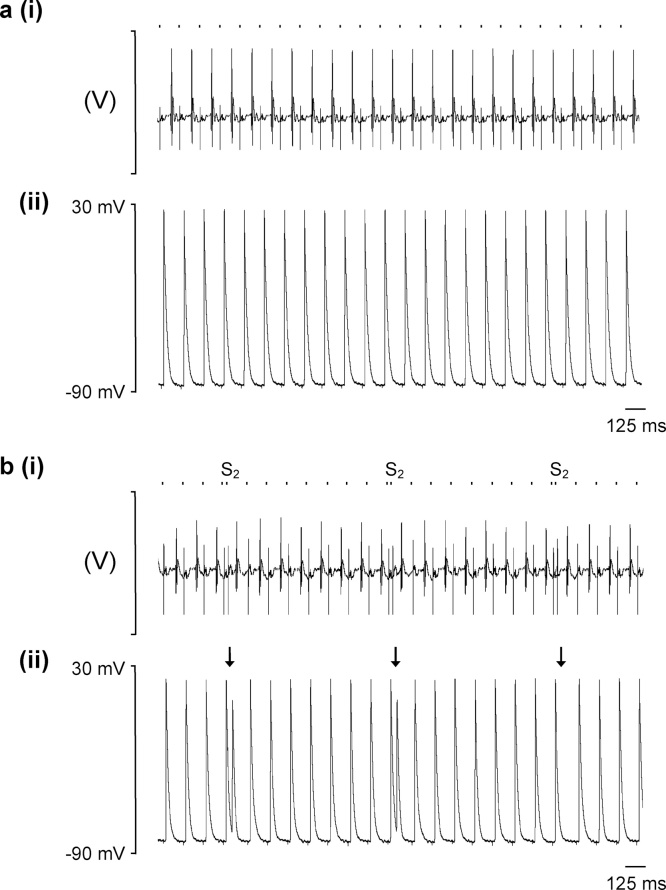
Typical recordings from Langendorff-perfused WT hearts during regular pacing and programmed electrical stimulation. Electrocardiograph (ECG) (i) and left atrial intracellular action potential (AP) recordings (ii) during (a) regular 8 Hz pacing and (b) a protocol imposing programmed electrical stimulation with a refractory outcome. The timings of stimulus delivery are given by the dashed bar above the AP recordings, and corresponding stimulation artefacts can be seen on the ECG and AP traces, preceding the respective complexes. In panel (B), arrows indicate the imposition of S2 extrastimuli. The first two S2 stimuli trigger APs, whereas the third S2 stimulus fails to elicit a response, thus representing a refractory outcome.